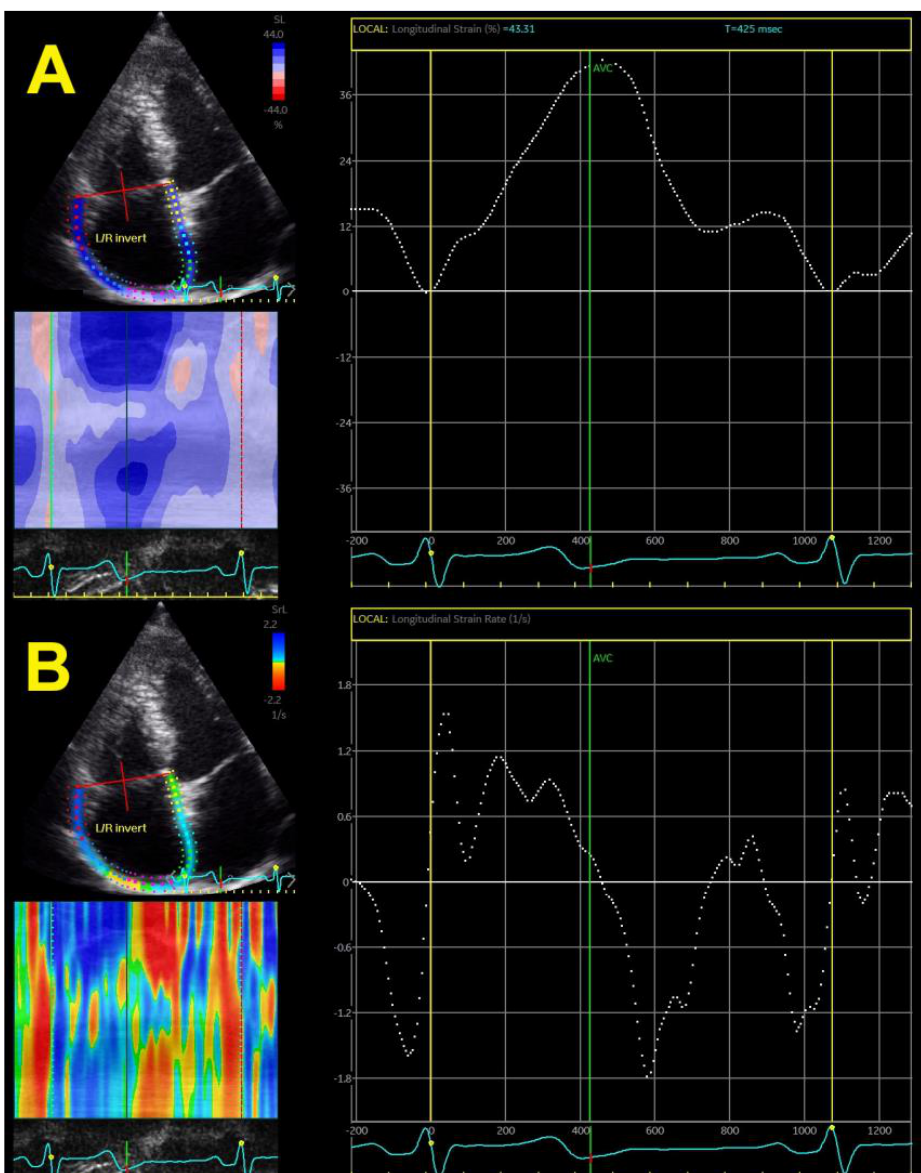
Figure 4. Two-dimensional right atrial strain ( A ) and strain rates ( B ).